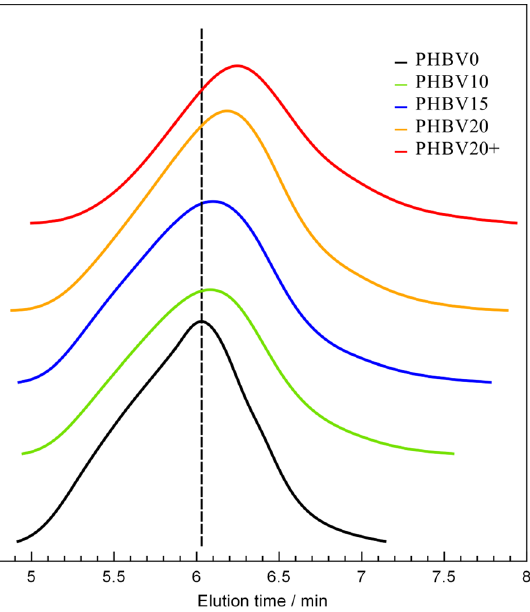
Figure 2. GPC chromatograms for the untreated and LiBH 4 ‐ treated PHBV electrospun fibers. The decrease in weight-average molar mass was rather small when the reduction was carried out for up to 20 min and at a concentration of the borohydride solution equal to 0.005 mol/dm 3 . If the degradation was conducted for 20 min in a 0.0075 M solution of LiBH 4 , the decrease in the molar mass was more pronounced. Such a substantial decrease may indicate that the degradation of PHBV chains occurs in deeper and deeper layers of the fibers, which is undesirable. Therefore, a reaction time of 20 min at a LiBH 4 concentra ‐ tion of 0.005 mol/dm 3 was determined as the upper limit of the fiber modification condi ‐ tions. It is also worth mentioning that the modification with LiBH 4 practically did not cause a change in the mass of the fibers (the mass loss was less than 0.4%). In other words, no erosion was observed in the fibers due to the borohydride reduction. 3.2. Effect of LiBH 4 Treatment on the Morphological Properties of Modified Materials The results of the molar mass measurements indicated that the degradation of PHBV microfibers could be limited to its outer layers. However, this required performing the modification under a low concentration of the reducing agent and within short time peri ‐ ods. This was important since the degradation affecting the inner layers of fibers may worsen their mechanical properties and eventually cause the destruction of the fibrous structure [31]. The fiber diameter and surface roughness measurements also supported the benign nature of the modification procedure. Both parameters were determined for the blank samples and the LiBH 4 ‐ modified ones. The root ‐ mean ‐ square (RMS) surface roughness values were calculated not for the fibers but the PHBV film prepared by the solvent ‐ casting method. Unlike casted films, fibrous mats have a highly porous structure, which makes it very difficult to measure their surface roughness. The determined RMS surface roughness and fiber diameters before and after the borohydride modification are given in Table 3. SEM images of the unmodified and modified electrospun PHBV fiber mats can be seen in Figure 3. Table 3. Film surface roughness and mean fiber diameter of the electrospun mats before and after treatment with LiBH 4 . Sample